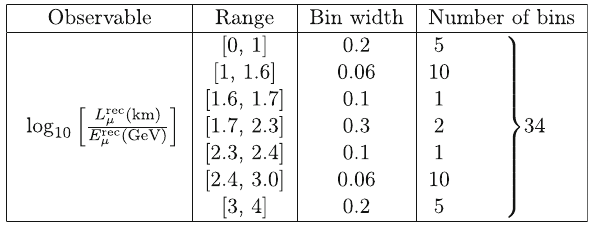
events of 10-year simulated